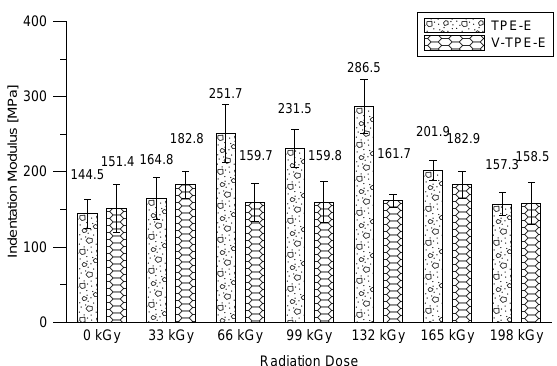
Figure 14. Nano-indentation modulus dependence on the radiation dose.